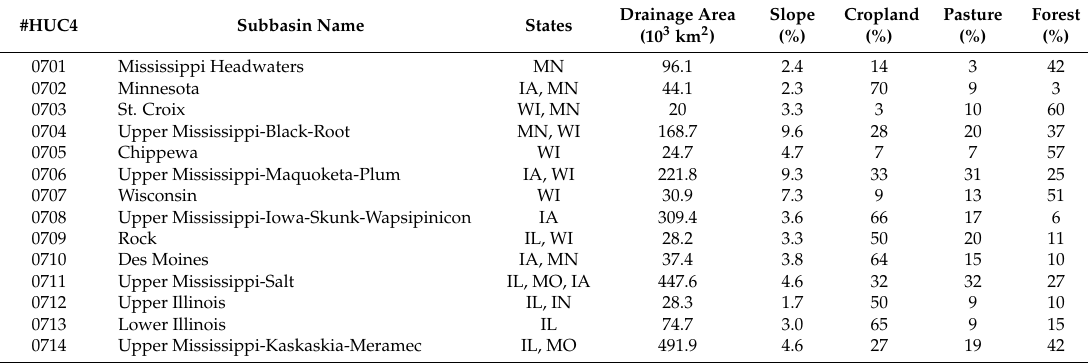
Table 1. A summary of 14 HUC4 subbasins in the UMRB along with information on main land use types for each